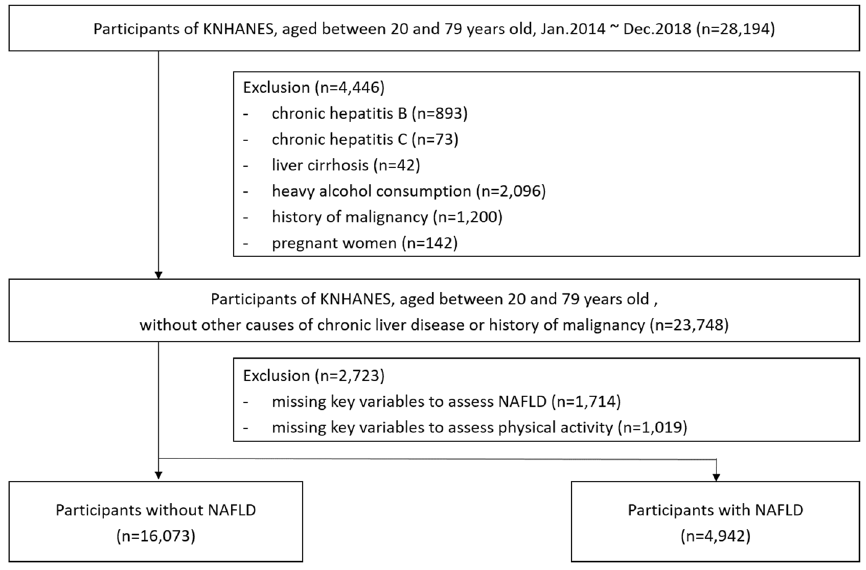
Figure 1. Flowchart showing the selection of study